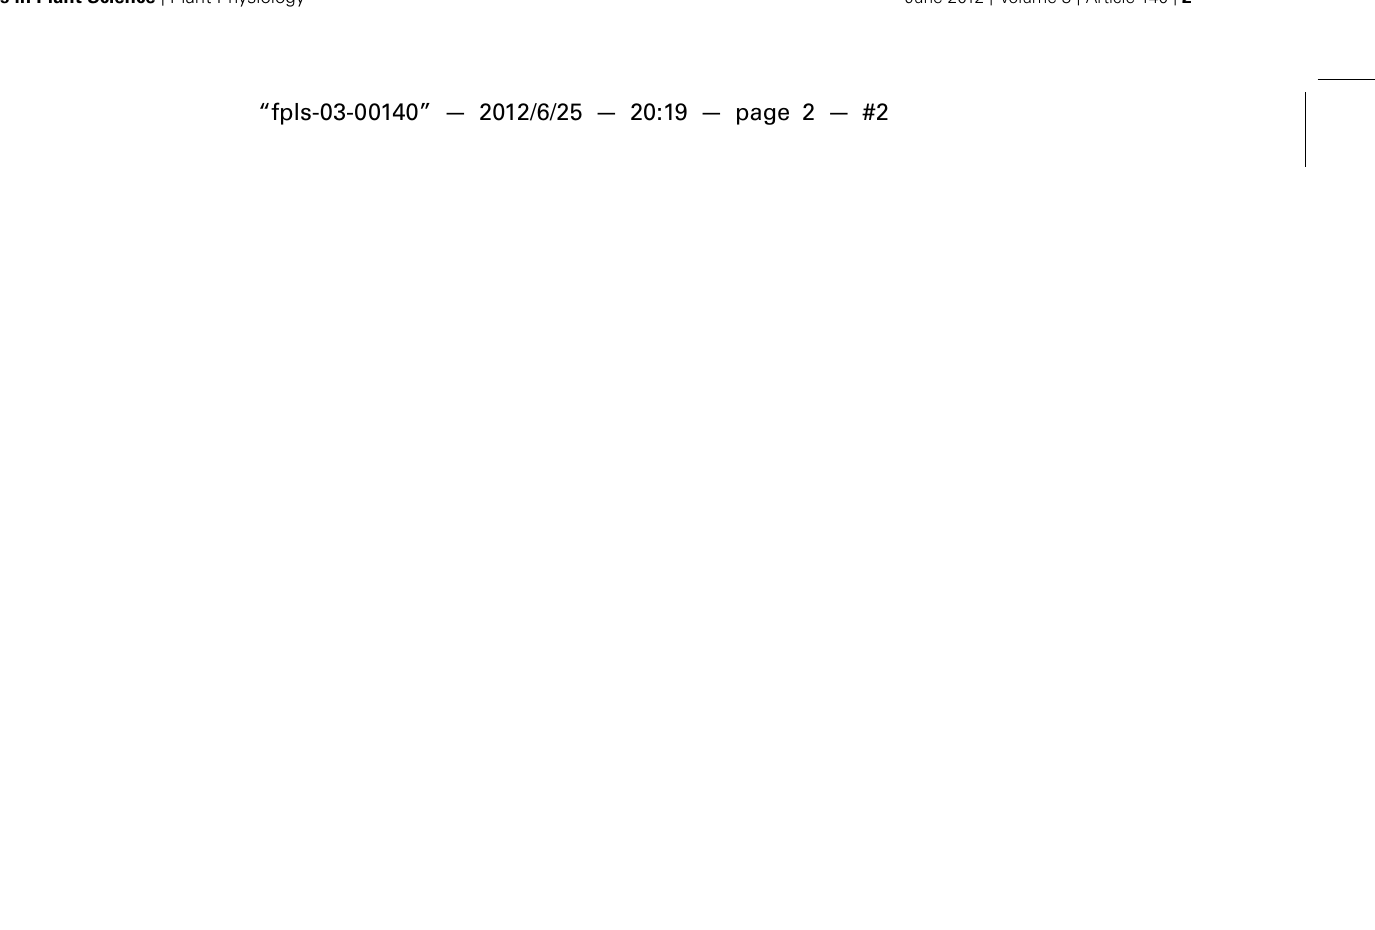
from Qi etal., 1991). (C) Primary structure of a representative Hyp-AG polysaccharide (AHP-1) released by base hydrolysis from a synthetic AGP (Ala-Hyp) 51 from tobacco BY2 cells (modified fromTan etal., 2004). (D) Larch AG structure (modified from Ponder and Richards,